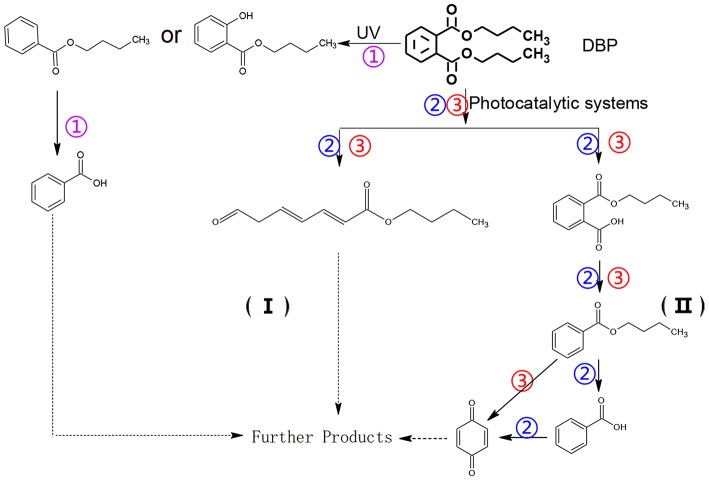
Proposed pathway for DBP degradation in different systems (① UV system; ② UV/TiO2 system; ③ UV-Vis/Bi2WO6 system).